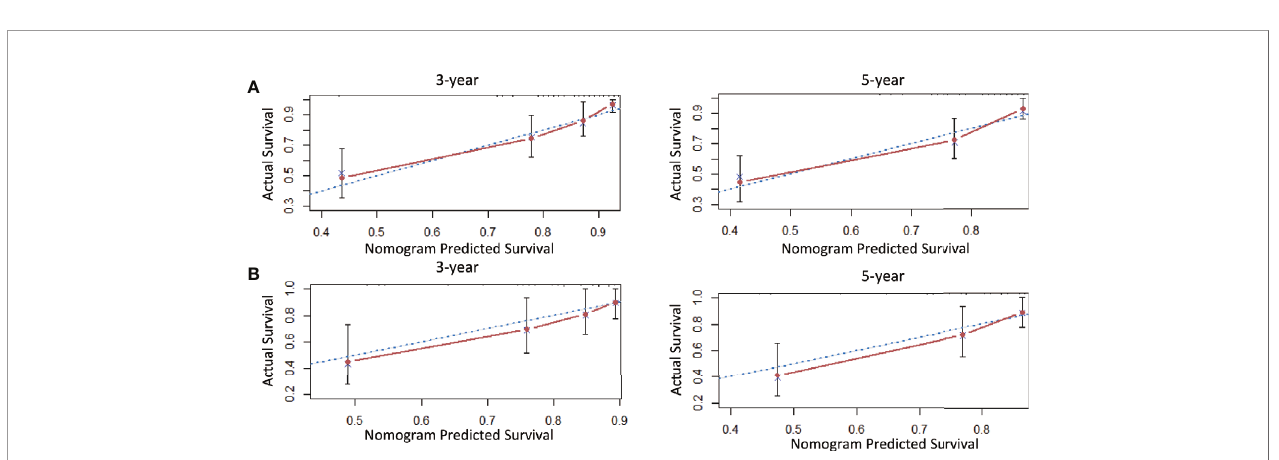
FIGURE 3 | The calibration curve for internal and external validation of the nomogram model. Description: (A) The calibration curve for internal validation of the nomogram model for predicting the RFS in EC; (B) The calibration curve for external validation of the nomogram model for predicting the RFS in EC (notes: The blue dotted line: Reference line; The red solid line: The prediction curve given by the model).